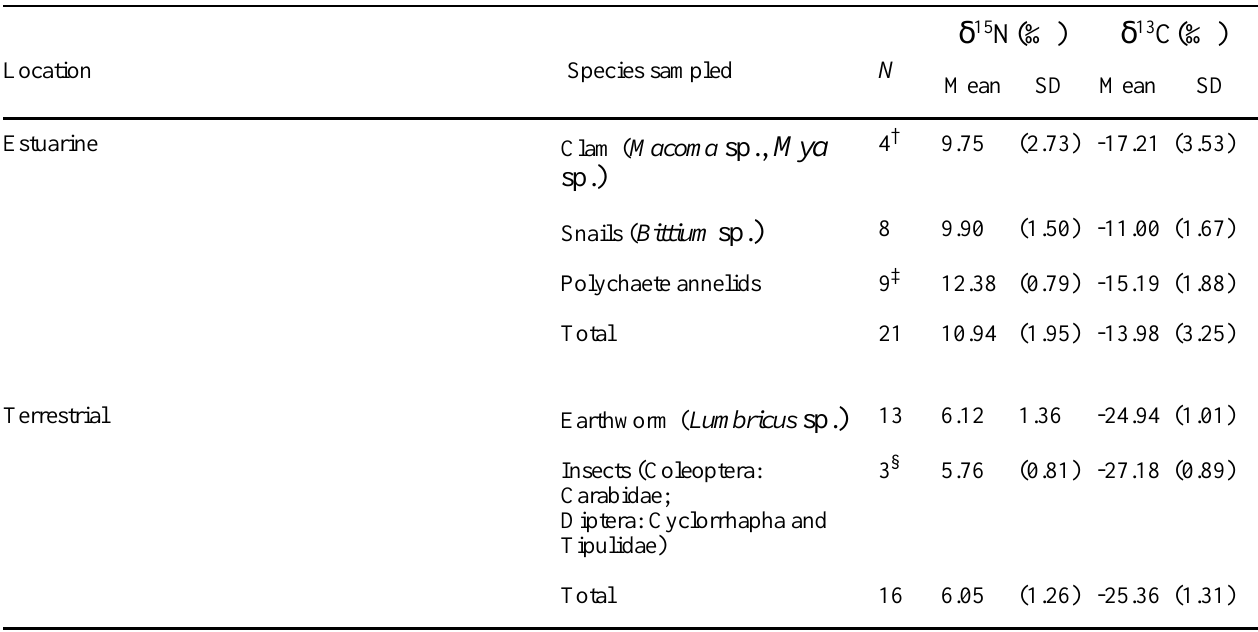
Table 1 . Isotopic values for estuarine and terrestrial invertebrate samples of Dunlin prey